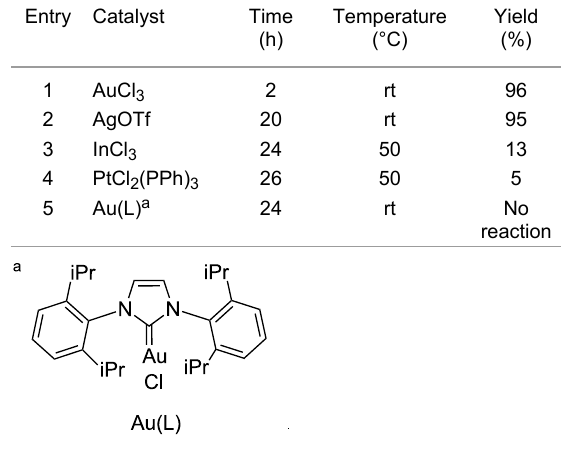
Table 1: Optimization of cyclization reaction of 15